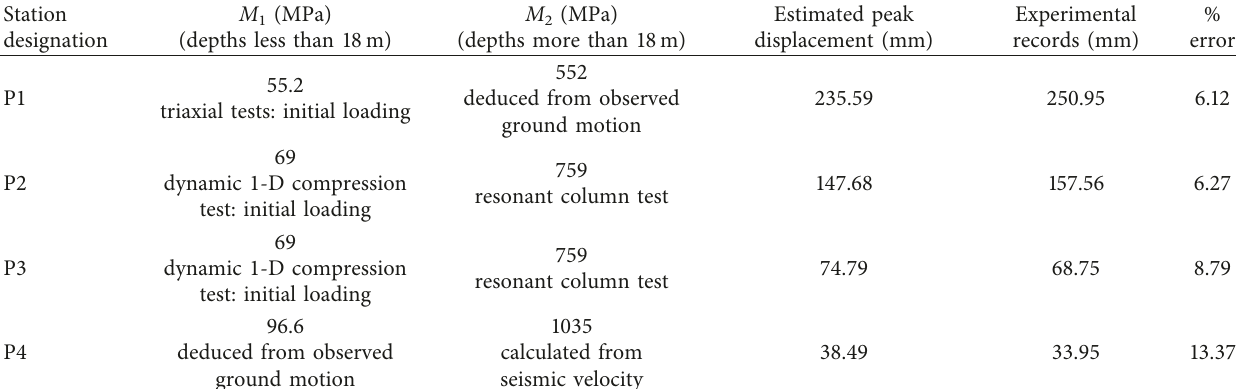
Table 6: Suggested combination of modulus values and corresponding estimated peak displacements.